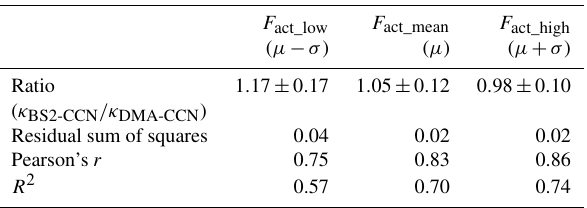
Table 3. The average and standard deviation of the ratio between κ from the DMA-CCN and BS2-CCN measurement and the good- ness of fit for the linear regression line. Three different statistical values are used to evaluate the goodness of fit: residual sum of squares, Pearson correlation coefficient, and coefficient of determi- nation ( R 2